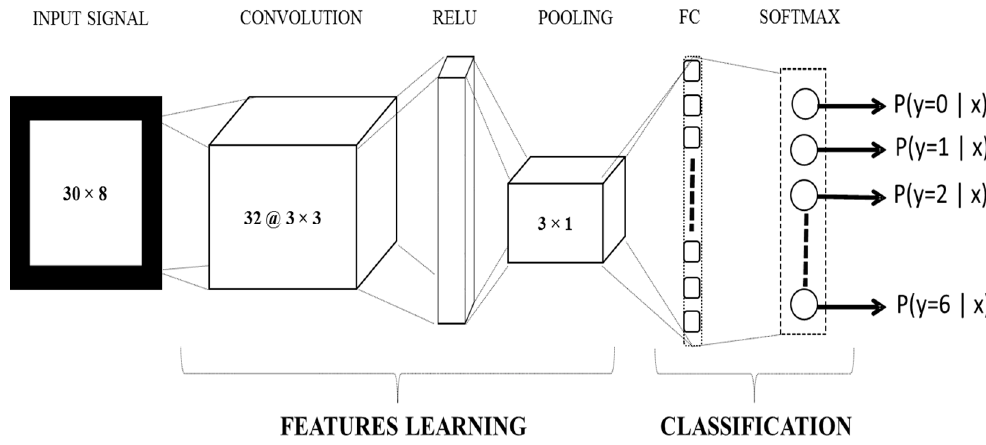
Figure 3. Block diagram of the convolutional neural network (CNN) used in this work. The input corresponds to a 150 ms (30 × 8 samples) window of eight channels. There were only single layers of convolution, Relu, pooling, and fully connected (FC) layers, while Softmax was used for classification. After several trials, the weights of the network were initialized randomly [20]. The parameters were identified with manual hyperparameter tuning [21,73], using the datasets of two randomly